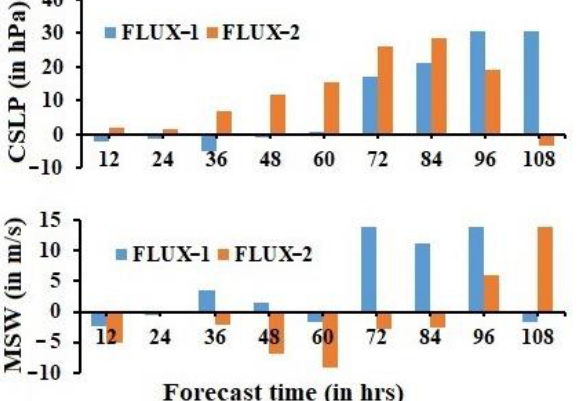
Figure 6. Model simulated intensity from the FLUX-1 and FLUX-2 experiments in terms of ( a ) CSLP (in hPa) and ( b ) wind speed (in m/s) along with IMD best-fit track dataset.